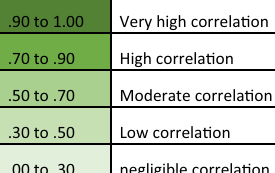
Figure 6. Cross-correlation coefficients displaying the linear association between the RSV of the term ‘protective mask’ and officially reported COVID-19 cases.